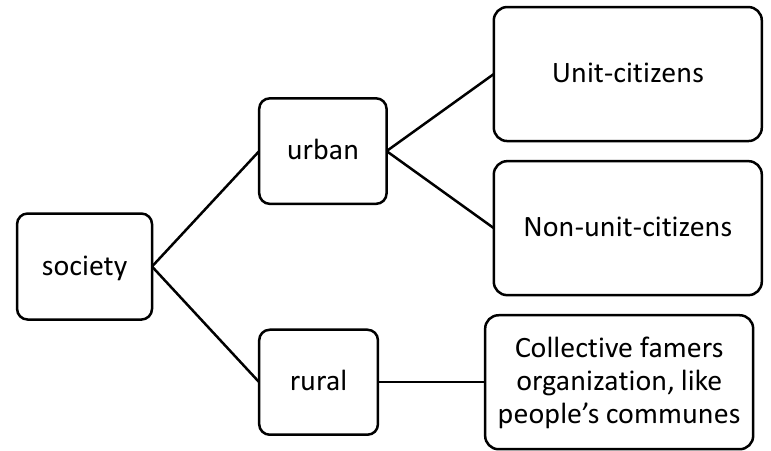
Fig. 7. The general pattern of social control at the initial stage of PRC (developed by the